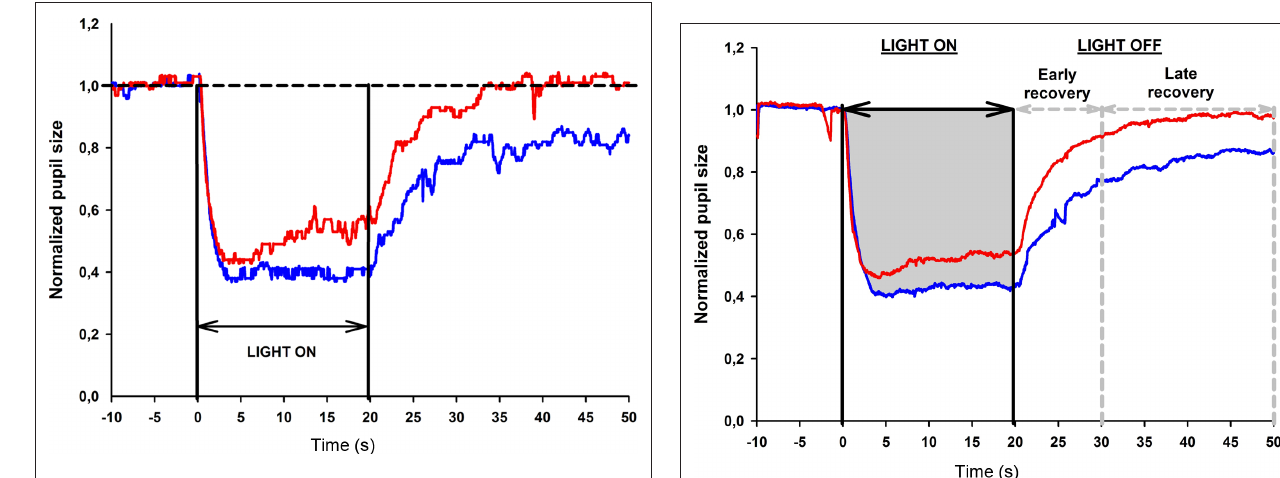
Figure 3 | Determination of the area under the curve (AuC) from the pupil response curve. The pupil size is plotted as a function of time under red and blue light stimulus conditions (red and blue lines, respectively, see also Figure 2 ). Pupil recording begins 10 s before light onset which is marked as time 0. The light stimulation is continuous for 20 s; after light offset, the pupil redilation is recorded for 30 s in darkness (time 20–50 s) and divided into two time windows: early and late pupil recovery. In this example, the AUC for the pupil response during 20 s of blue light stimulation is shown in